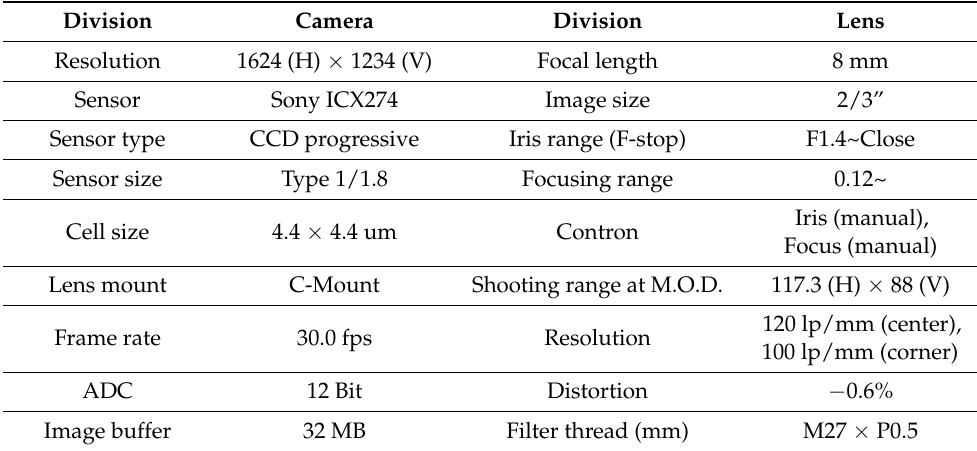
Figure 12. Image shooting environment. Table 2. Camera and lens specifications.